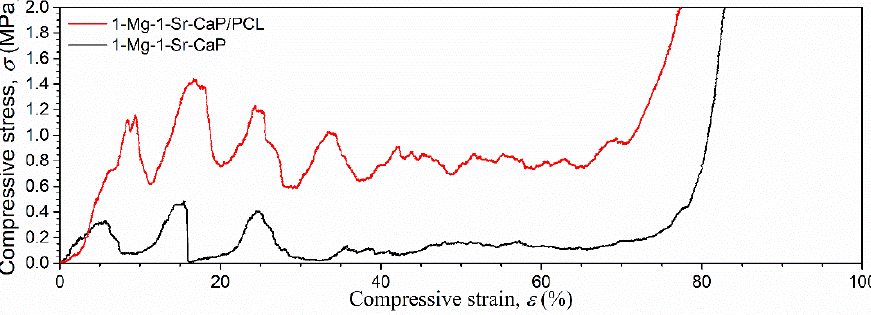
Figure 6. Typical compressive stress – strain curves for uncoated and PCL-coated scaffold.